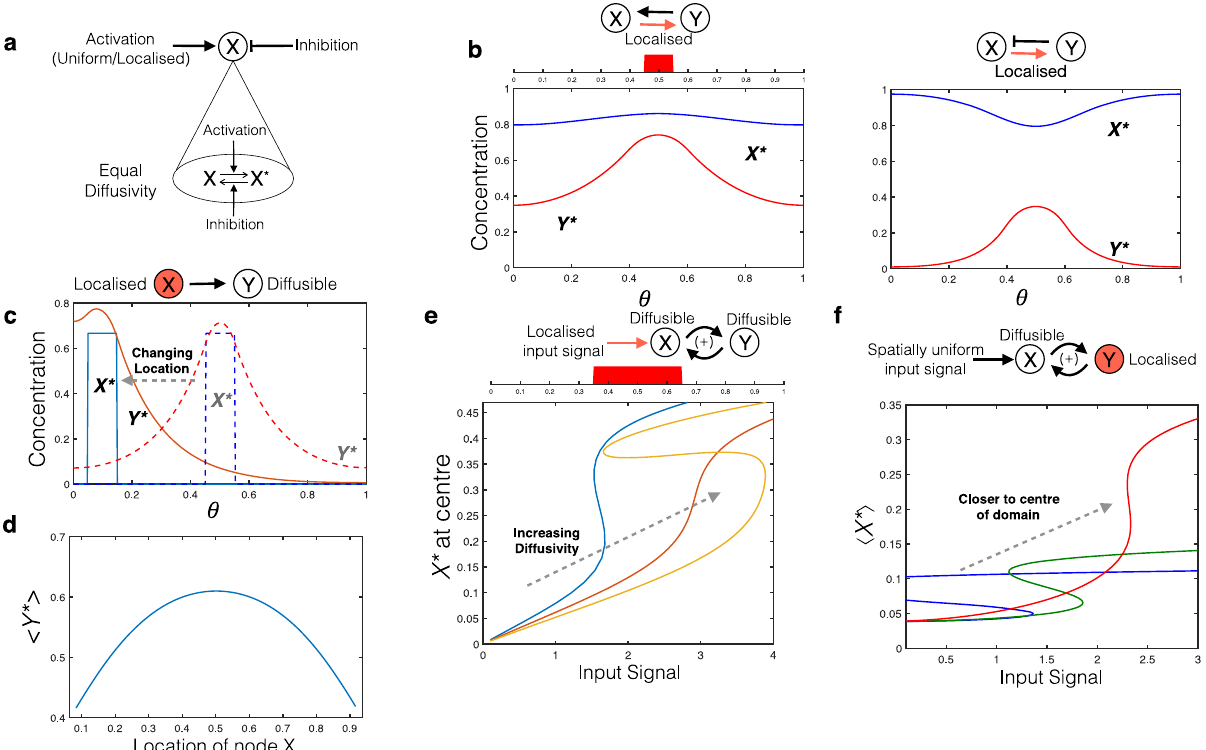
Fig. 2 Basic effects of localisation: location and diffusivity-dependent behaviour. In all fi gures that follow, θ denotes the spatial co-ordinate, and the concentration of the species plotted is the active form of the node in the associated motif. A shaded node in a motif denotes a localised node and a coloured arrow denotes a localised interaction. a Schematic of a single node highlighting how activation or inhibition is implemented. b When an interaction is localised in a feedback motif, the resulting gradients of species can be commensurate or opposing depending on the nature of the non-localised interaction (blue curves denote X * , red curves denote Y * ). c Altering the location of localisation of input node X introduces location dependence of the steady state of a moderately diffusible output node Y, without affecting X itself. A higher level of output is attainable locally (for a fi xed input level),when the localisation is closer to a closed boundary (solid curves denote the case where localisation is close to the boundary, dashed curves, the case where localisation occurs in the middle of the domain). d This location dependence is also re fl ected in other measures such as the spatial average of Y (hereafter spatial average is denoted by < >). In contrast to ( c ), the maximum value of the average occurs when X is localised in the centre of the domain. e Diffusivity-dependent behaviour: The bistable behaviour of a two-node positive feedback motif with localised input signal is affected by the (equal) diffusivity of the nodes. The system exhibits bistability for low and higher diffusivities, and loses it at intermediate diffusivity. f The same motif, with one of the nodes localised, can exhibit location dependent bistable behaviour, with locations closer to a boundary favouring bistability. In ( e ) and ( f ) curves with different colours denote different bifurcation curves as the diffusivity is